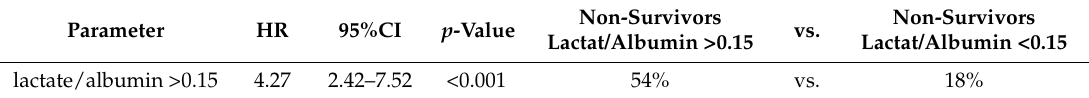
Table 3. An increased lactate/albumin ratio is associated with adverse in-hospital outcome. Parameter